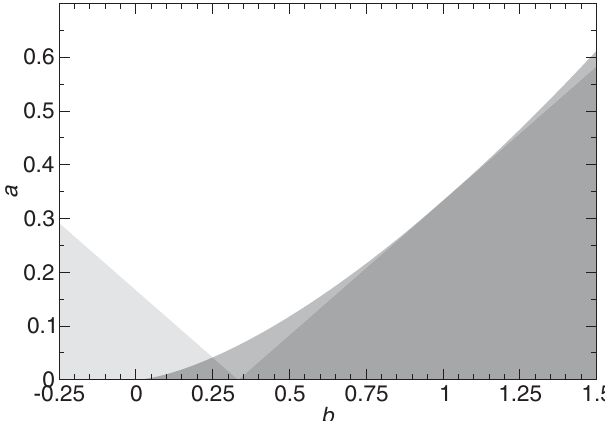
FIG. 3. Region of a - b parameter space for which particles can be accelerated from p (cid:2) 0 to p (cid:2) 1 , shown in white. Particles will not accelerate from p (cid:2) 0 to p (cid:2) 1 because of condition (9) (light gray) or condition (8) (medium gray) or both (darker